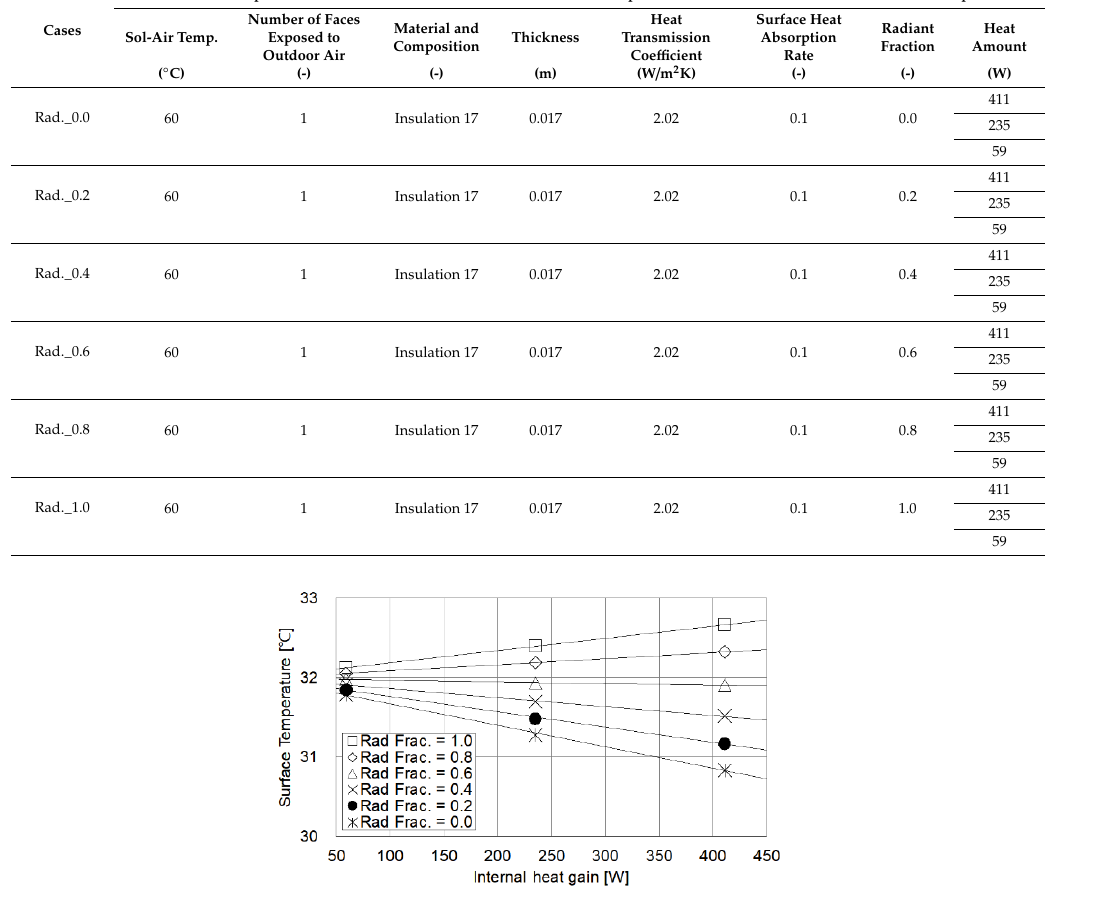
Figure 13. Internal heat gain and surface temperature for radiant fraction (exposed to outdoor air).